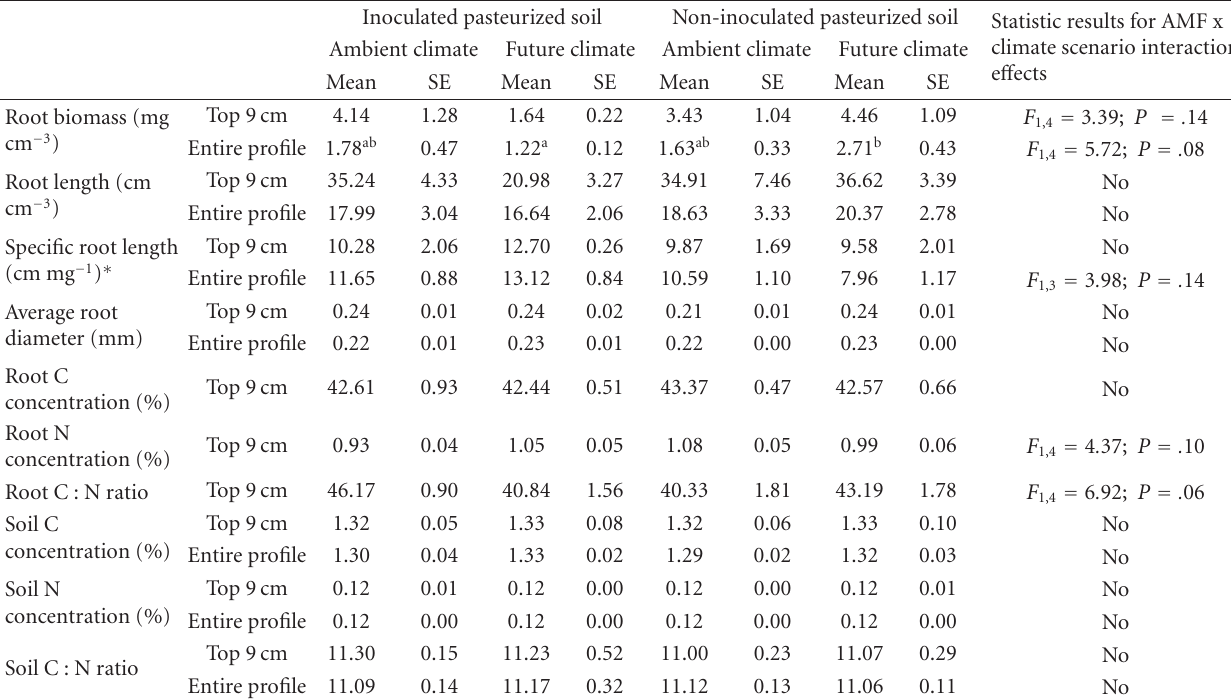
Table 1: Root and soil characteristics for the di ff erent treatments (mean and one standard error (SE)). Letters indicate significant di ff erences within one row ( P ≤ . 10; nested two-way ANOVA). Absence of letters denotes the absence of significant di ff erences for the specific parameter. We also report (borderline) significant treatment (AMF or climate scenario) e ff ects and AMF x climate scenario